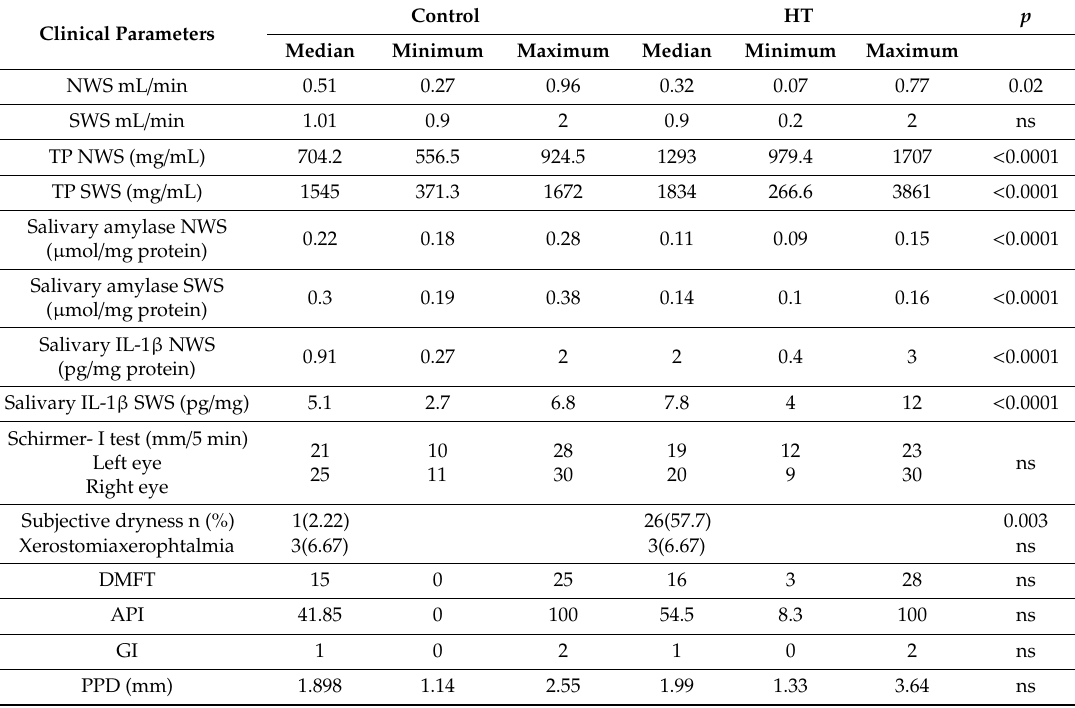
Table 2. Salivary gland function and dental indices of the patients and the control group. Clinical